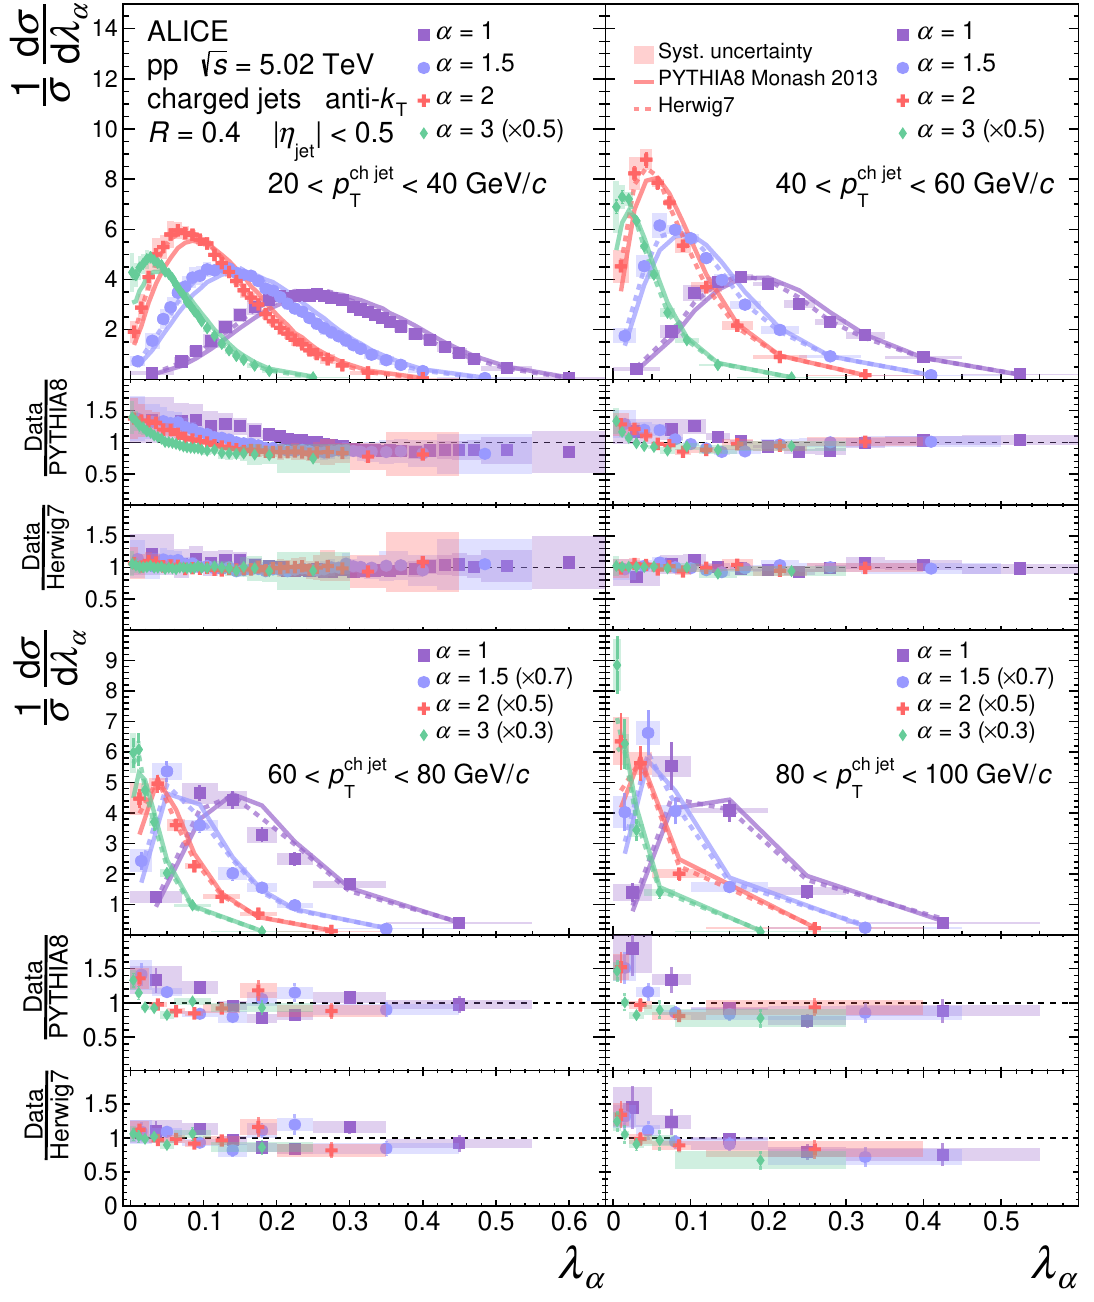
Figure 1 . Comparison of ungroomed jet angularities λ α in pp collisions for R = 0 . 4 to MC predictions using PYTHIA8 and Herwig7, as described in the text. Four equally-sized p ch jet with edges ranging between 20 and 100 GeV /c . The distributions are normalized to